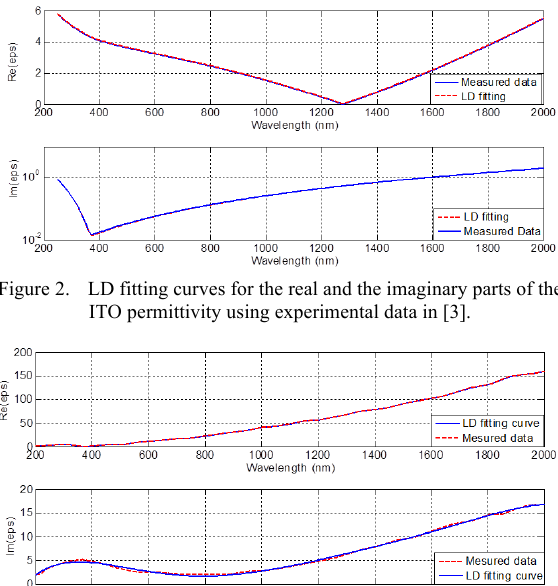
Figure 1. LD fitting curves for the real and the imaginary parts of the Ag permittivity using experimental data in [3].